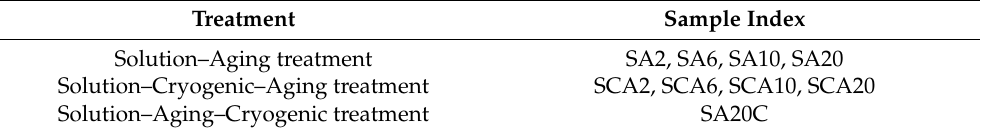
Figure 1. Program-controlled SLX-80 cryogenic system. Table 2. Heat and cryogenic treatment schemes of the 15%SiCp/2009 aluminum matrix composites. The alphabetic order of each sample index indicates the execution sequence of treatments. For example, SCA2 indicates that the sample was treated by solution treatment, cryogenic treatment, and aging treatment for 2 h successively.